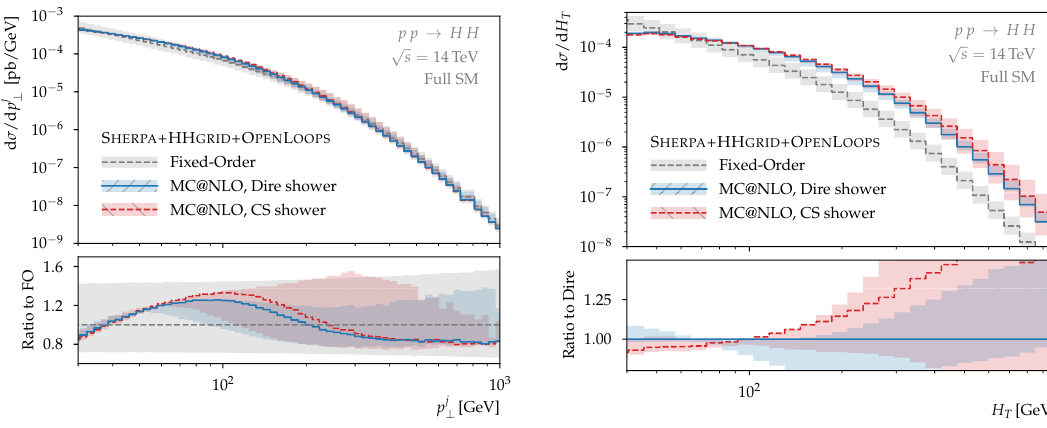
Figure 9 . Parton shower e(cid:11)ects on the leading jet transverse momentum (left panel) and on the scalar sum of jet transverse momenta. The uncertainty band around the (cid:12)xed-order result is obtained through variations of (cid:22) F and (cid:22) R . Uncertainties on the MC@NLO results are generated by varying (cid:22) PS .